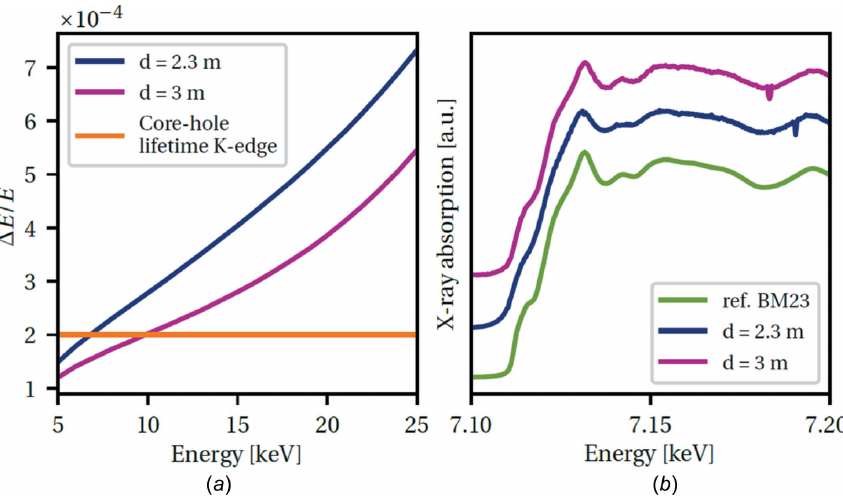
Figure 2 ( a ) Energy resolution as a function of energy for a Bragg polychromator using an Si(111) crystal focusing at a distance 1.1 m. The detector is placed at 2.3 m (blue curve) and 3 m (purple curve). ( b ) XANES spectra of Fe, where the blue and purple lines are spectra acquired on ID24 under the same conditions, and the green line is a reference spectrum from